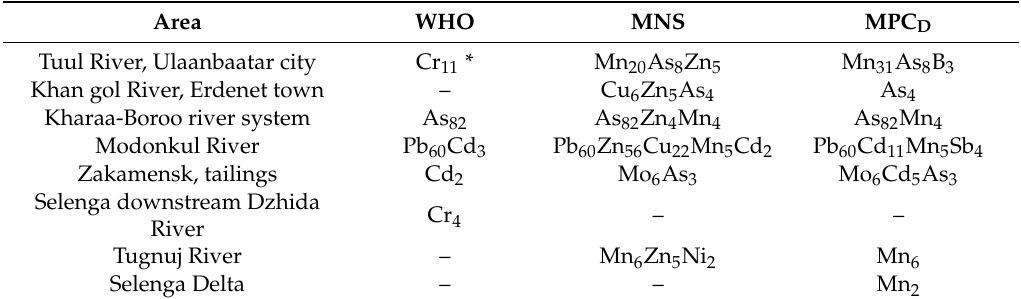
Table 4. The main pollutants of the areas with high anthropogenic impact in the Selenga River basin relative to national and international water quality